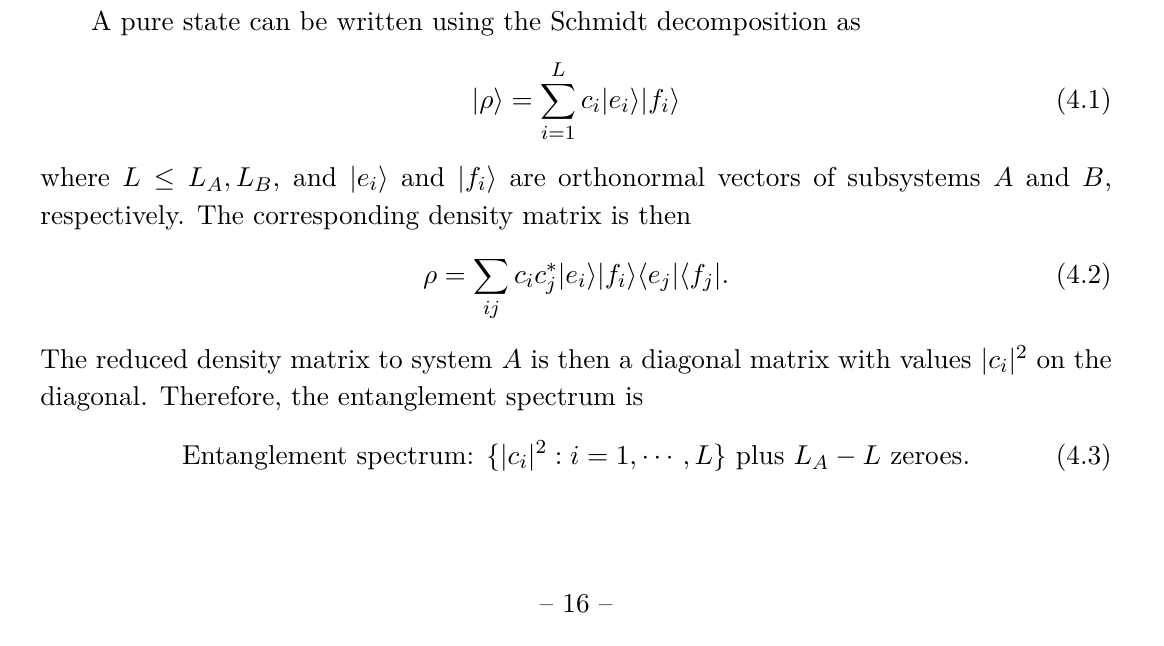
Figure 9 . The negativity spectrum for the two-tensor network as we vary w E = w = 2 , and N = 2 . There is a topological transition between Phase 2 (upper w B = 4 , w C C 2 1 left) with two connected components and Phase 4 (lower right) with a single connected